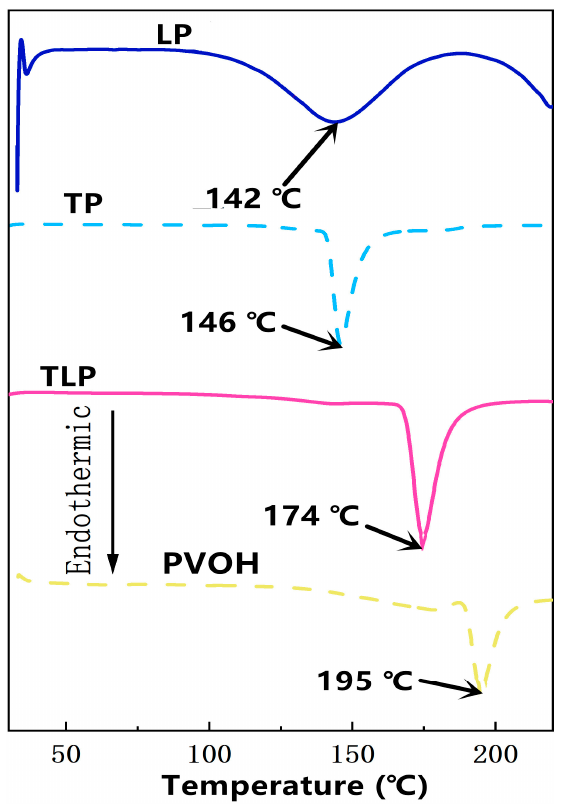
Figure 4. DSC thermograms of PVOH, tannin-PVOH (TP), Lignin-PVOH (LP) and tannin-lignin-PVOH (TLP) films.